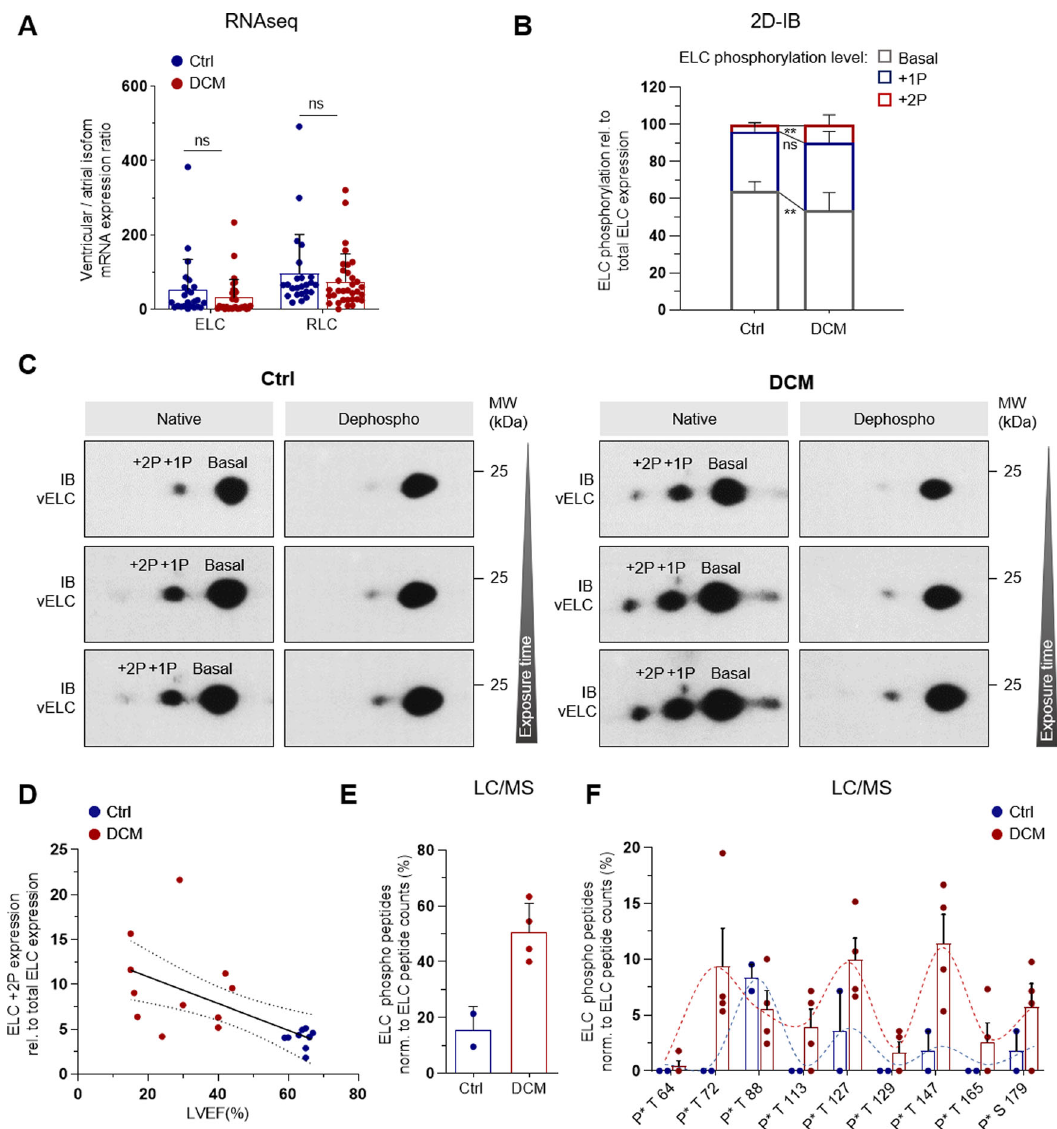
Fig. 8 | ELC-phosphorylation is regulated in human dilated cardiomyopathy. A Ratio of ventricular (v) MLC and atrial (a) MLC mRNA expression in human left ventricular tissue of DCM patients and HTX controls (HTX: n =28; DCM: n =44). Samples were analyzed by deep mRNA sequencing (mRNAseq) 38 . Data are mean±SEM. Statistical signi fi cance was tested by two-tailed unpaired Student ’ s t-test. B Quanti fi cation of relative basal (Basal) and phosphorylated (+1P,+2P) ELC protein illustrated as averaged intensity normalized to total ELC protein (Control: n =9; DCM: n =11). 6 HTX controls (Supplementary Table 1) and 3 healthy controls were included. Data are mean±SD. ** P <0.01 by the analysis of two-tailed unpairedStudent ’ st-test. C RepresentativeELC2Dimmunoblot (IB)of humanLVhearttissueofaDCMpatientandahealthycontrol.NativeELCprotein forms (left panel) and ELC protein forms after in-vitro dephosphorylation (right (vELC) to atrial myosin light chain (aELC) expression 11 , analysis of a DCM cohort by mRNA-seq didnot show signi fi cant isoform expression changes of ELC (Fig. 8A). Hence, we focused on post-translational ELC modi fi cation as a potential contributor to adaptive or maladaptive changes in ELC function.